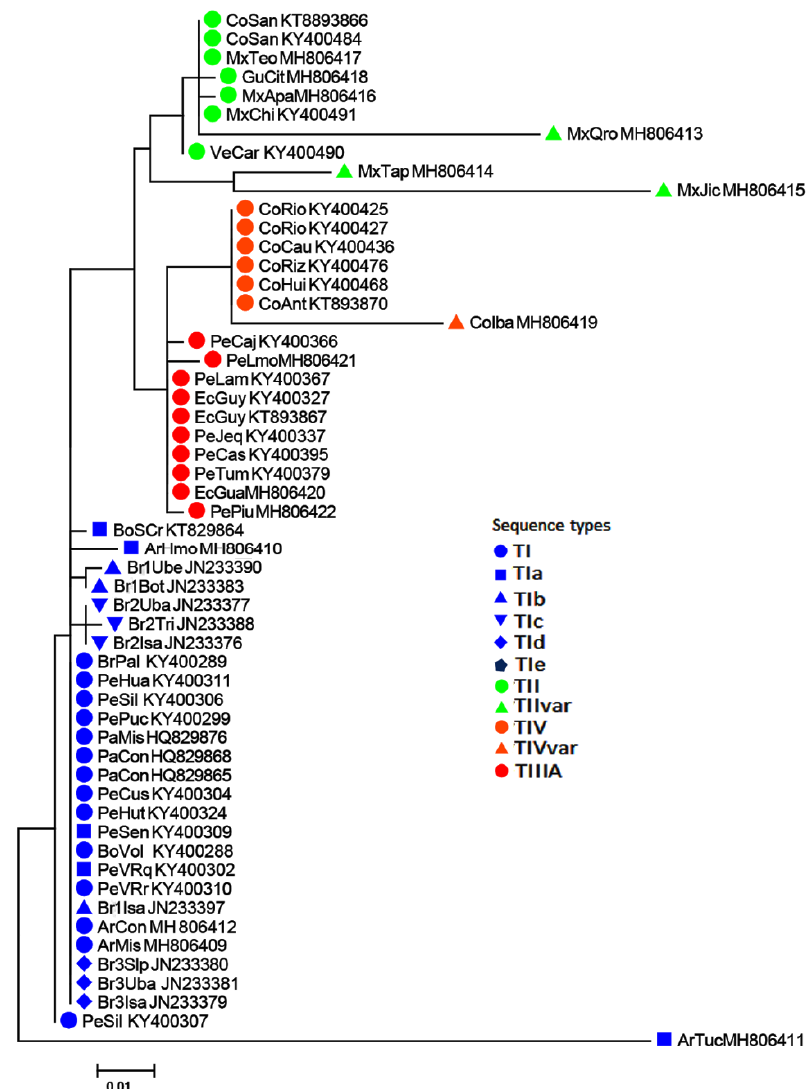
Figure 5. Phylogenetic relationships of the ITS1 sequences of the AF complex. The evolutionary history was inferred by using the maximum likelihood method based on the general time reversible model. The tree with the highest log likelihood is shown. Initial tree(s) for the heuristic search were obtained by applying the BioNJ method to a matrix of pairwise distances estimated using the maximum composite likelihood (MCL) approach. A discrete gamma distribution was used to model evolutionary rate differences among sites. The numbers on the branches are bootstrap values >50% (1000 replications). All positions containing gaps and missing data were eliminated.